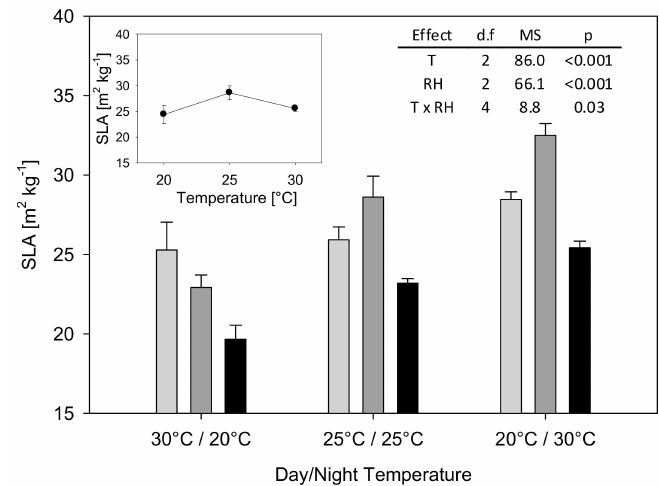
Figure 2. Average plant specific leaf area (SLA) after two weeks exposure to varying day and night temperature and RH regimes. Light grey bars: RH day / night 40 / 90%; dark grey bars: RH day / night 65 / 65%; black bars: RH day / night 90 / 40%. Insert 1: SLA at di ff erent constant day and night temperatures and constant 65% RH. Insert 2: Analysis of variance for SLA at di ff erent day and night temperatures and RH regimes. In both, main figure and insert 1, mean values with standard errors ( n = 3) are presented. Abbreviations: T: temperature; d.f.: degrees of freedom; MS: mean squares.